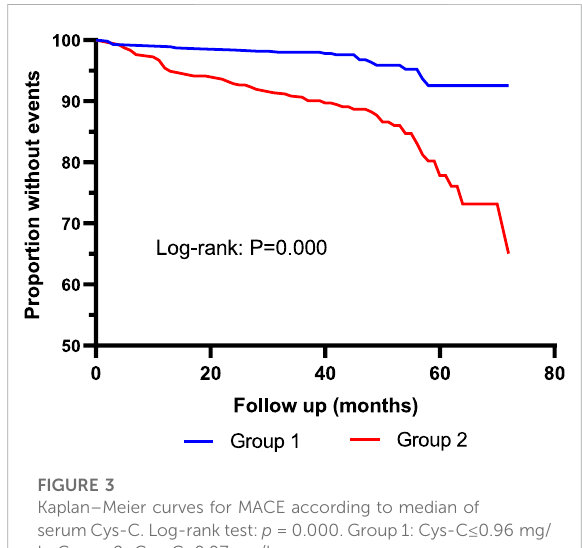
FIGURE 1 Flowchart of participant selection. OSA: obstructive sleep apnea; MI: myocardial infarction.